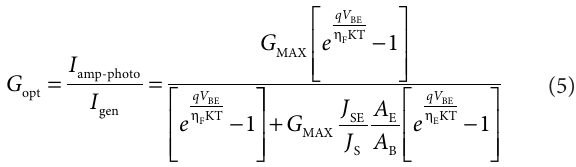
ratio of (hole) minority carrier injection to InP, to (electron) majority carrier injection to GaAsSb. In the expression for γ − 1 , D n and D p are the minority carrier diffusion coefficients in GaAsSb and InP layers, W p and W n are the respective layer thicknesses, and N pA and N nD are the doping concentrations (acceptor and are the donor, respectively). Furthermore, m m ep effective masses of electron and hole in GaAsSb and InP layers, and E gp and E gn are the relative bandgap energies. In the expression for I S , n iP is the GaAsSb intrinsic carrier concentration, and η F and η E are the injector and trapping layer current ideality factors. Using published experimental parameters given in http://www.ioffe.ru/ SVA/NSM/, Maneux et al. (2005), and Iverson et al. (2014), we find γ = 2.95 × 10 10 . Under large optical power levels (tens of microwatts), optical gain, which is the ratio of I amp-photo to I gen has maximum value of G its value can be read from measurement data of Figure 15B or Figure 16